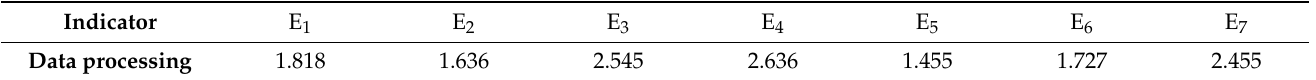
Table A8. Data processing of environmental risk (E).